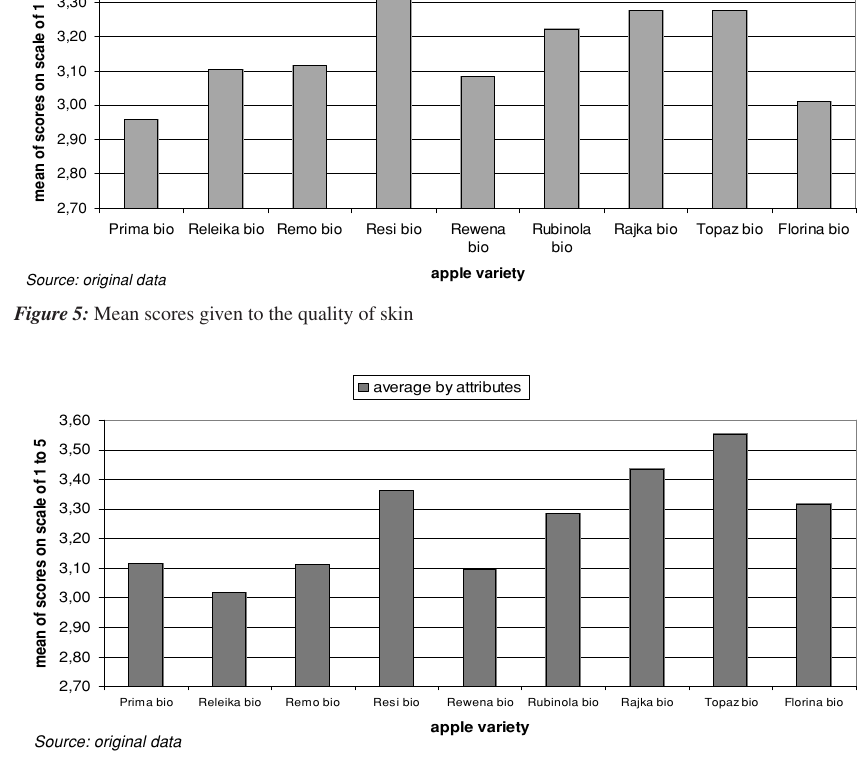
Figure 6: Mean values of the scores of five attributes